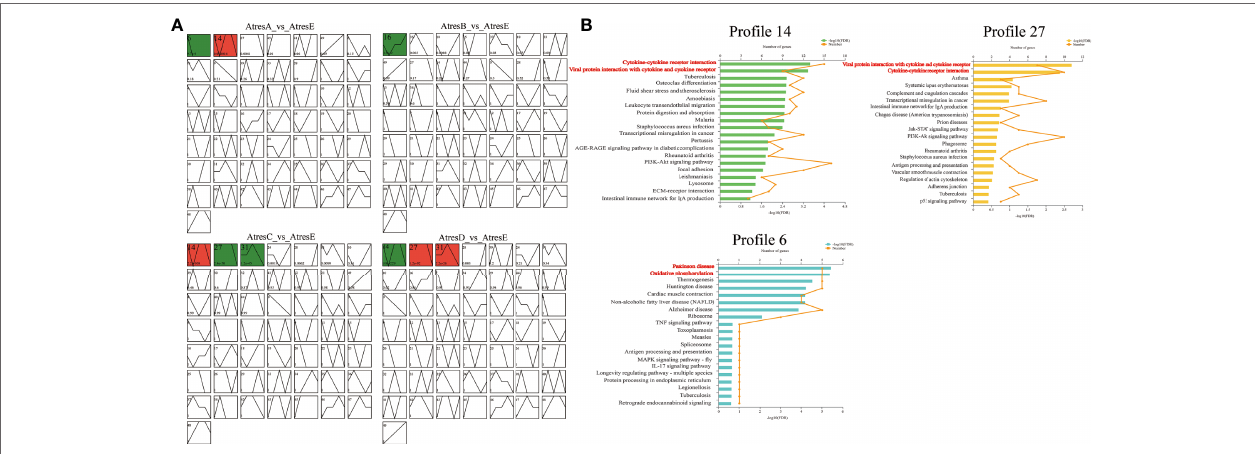
FIGURE 6 | Module profiles and functional enrichment analysis of the genes in five stages of follicle atresia. (A) Module profiles of the genes in AtresA, AtresB, AtresC, and AtresD compared with AtresE, respectively. The STEM analysis shows genes expression trends. The broken line represents the trend of genes expression levels with time, the colored trend graphs are the significant change trends, and the same color represents the same cluster. (B) Kyoto Encyclopedia of Genes and Genomes (KEGG) pathway enrichment analysis results for the genes clustered in profiles 14, 27, and 6 among the five stages.